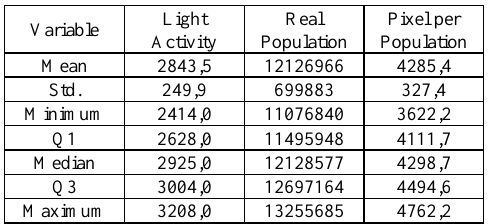
Table 2. Basic statistical parameter values for light activity